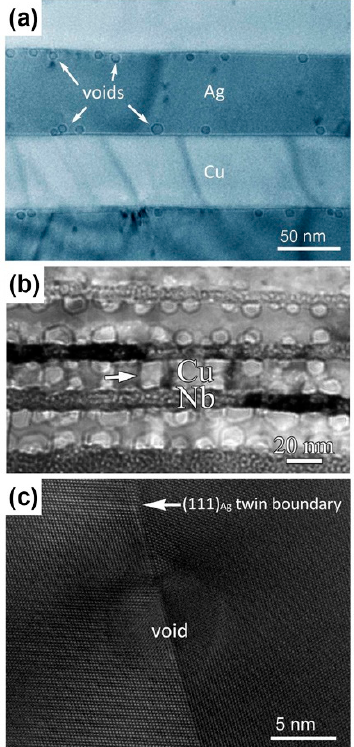
Figure 6. ( a ) Over-focus TEM image of the Cu / Ag composite after He ion irradiation at 450 ◦ C [33]. ( b ) Under-focus TEM image of the ARB Cu / Nb nanolayered composites after He ion irradiation at 450 ◦ C [22]. ( c ) High resolution transmission electron microscopy (HRTEM) image shows void wetting of a coherent (111) Ag twin boundary [33].